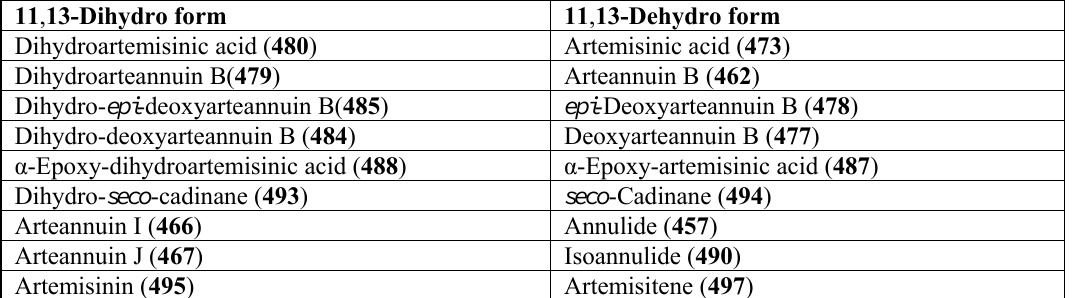
dihydro- epi -deoxyarteannuin B ( 485 ), arteannuin M ( 470 ), the seco -cadinane ( 493 ), the tertiary hydroperoxide of dihydroartemisinic acid ( 481 ), dihydro-deoxyarteannuin B ( 484 ), deoxyartemisinin ( 499 ), arteannuin K ( 468 ), arteannuin L ( 469 ), arteannuin H ( 465 ), arteannuin I ( 466 ), arteannuin J ( 467 ) and  -epoxy-dihydroartemisinic acid ( 488